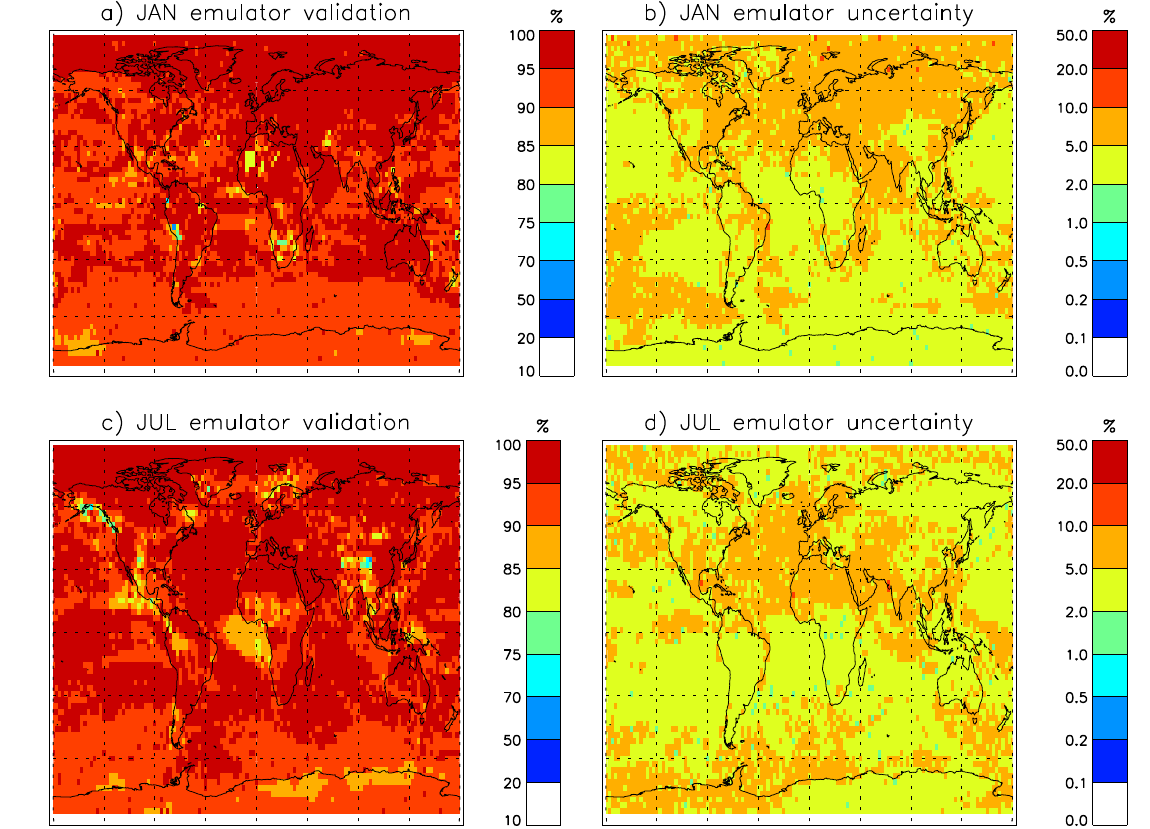
Fig. 4. Global validation of emulator-predicted CCN. CCN concentrations predicted by the emulator are compared against CCN from 84 additional GLOMAP model simulations for every model grid box on the 915hPa model level. The fraction of GLOMAP simulations lying within the emulator 95% confidence interval for every grid box is shown for (a) January and (c) July. In (b) and (d) the emulator uncertainty is shown as the standard deviation around the mean due to the emulator uncertainty ( σ emulator ) divided by the standard deviation due to the uncertain parameters ( σ CCN , shown in Fig. 5). Thus, everywhere, the emulator uncertainty is less than 10% of the parametric